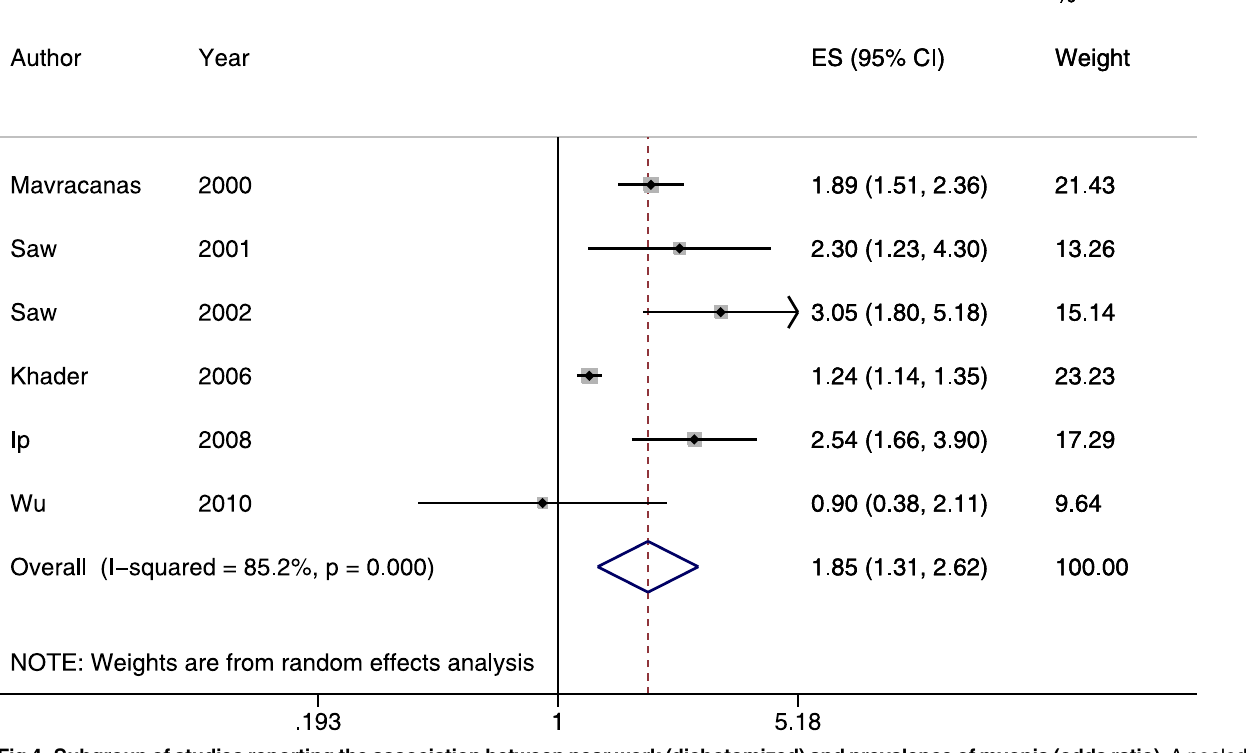
PLOS ONE | DOI:10.1371/journal.pone.0140419 October 20,